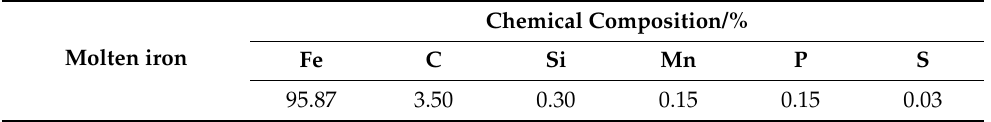
Table 2. Chemical composition of the molten iron sample.